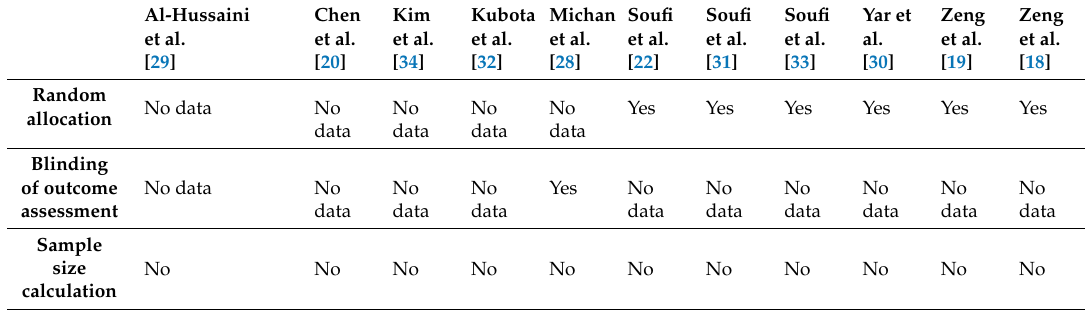
Table 2. Summary of risk of bias analysis in studies on resveratrol e ff ect in animal models of diabetic retinopathy. None of the studies provided data on allocation concealment or blinding the groups throughout the